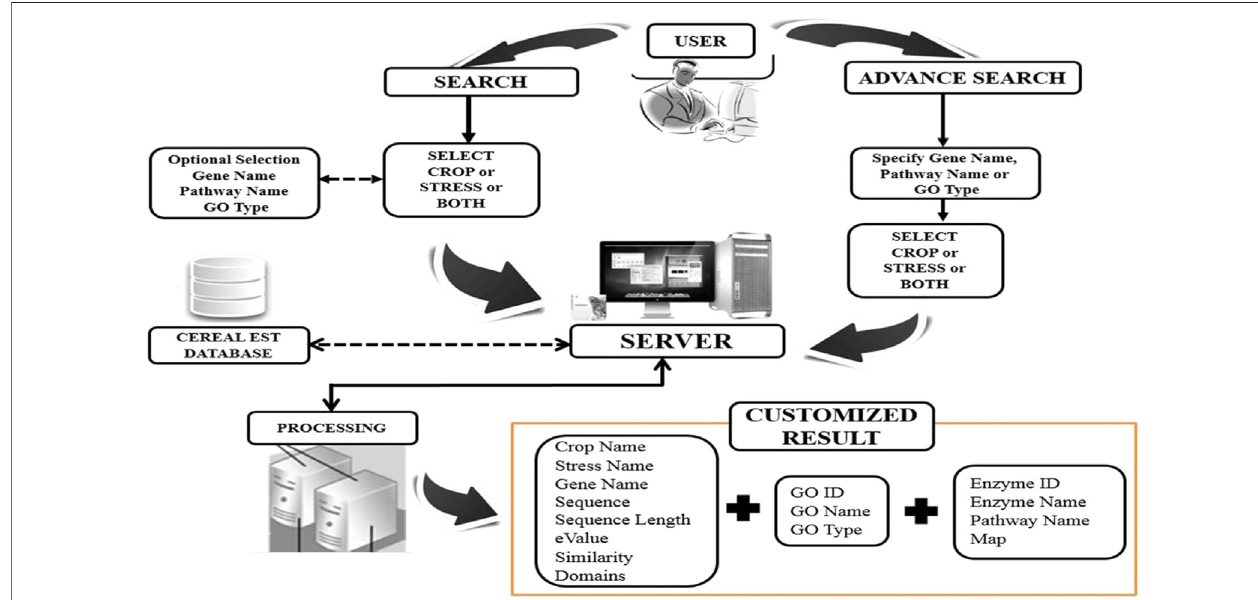
FIGURE 4 | Browsing CerealESTDb features diagram.